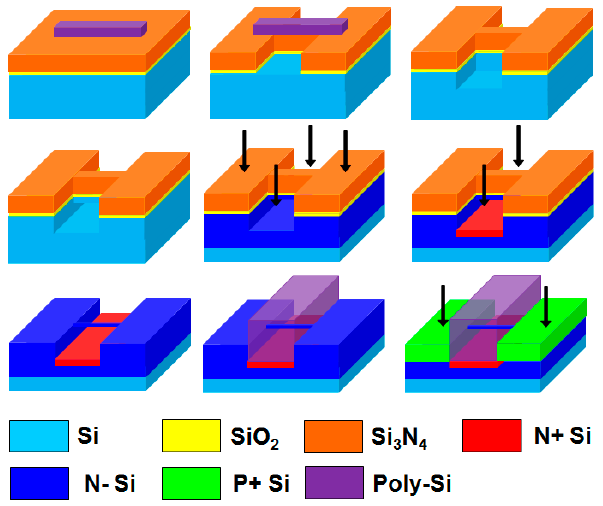
Figure 7. Process for fabricating P-type GAA SNWT by the TMAH wet etching technique on a bulk silicon substrate.